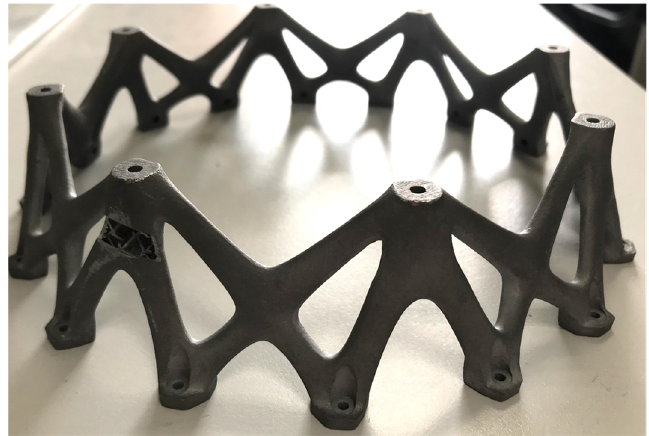
Figure 10. The products of the support structure based on additive manufacturing.